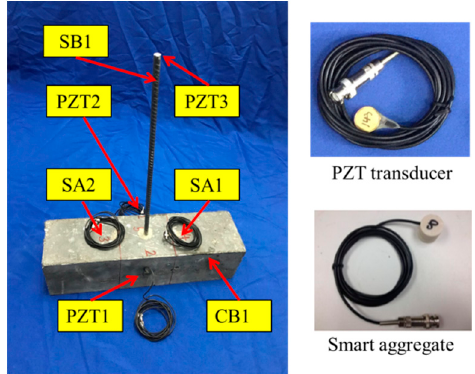
Figure 4. A specimen with an anchored steel bar.